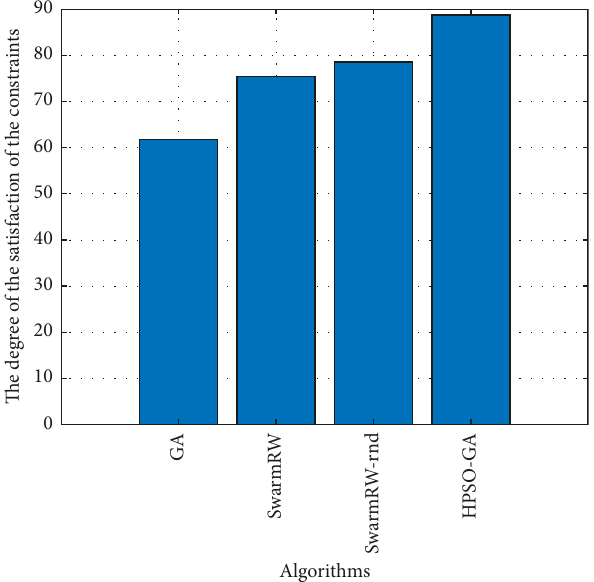
Figure 3: Comparison between HPSO-GA and the peer algorithms with respect to the CS (%).